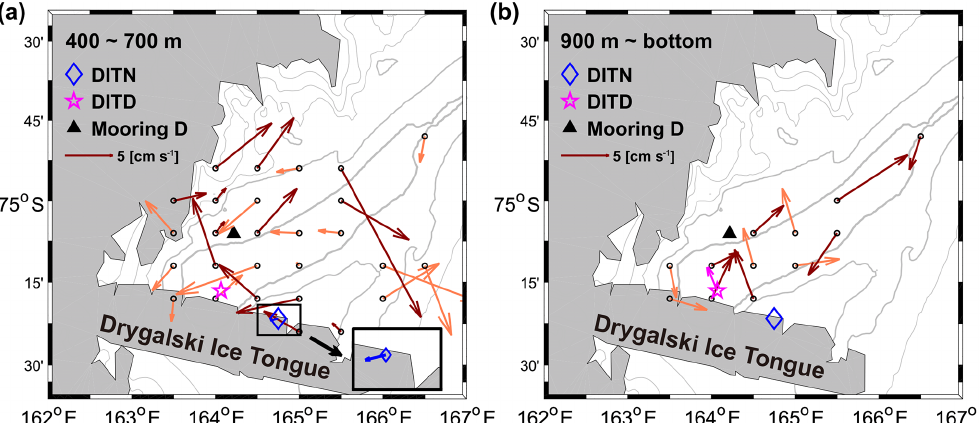
Figure 12. (a) Mean currents in a range of 400–700m during four hydrographic surveys (see details in Table 1). The LADCP data are arranged by averaging the data on a 0 . 5 ◦ × 0 . 1 ◦ grid. The averaged current vector from January to February at 660m in the DITN is denoted by a blue arrow. The inset shows the current vectors of the DITN. The current vectors mainly discussed in Sect. 4.2 are highlighted by dark red. The bold gray line indicates the 1000m isobaths, and the interval between the thinner gray lines is 200m. A scale arrow is denoted in the left part of the figure. (b) The same as Fig. 12a, but for the range of 900m–bottom. A magenta arrow shows the averaged current vector from January to February at 1222m in the